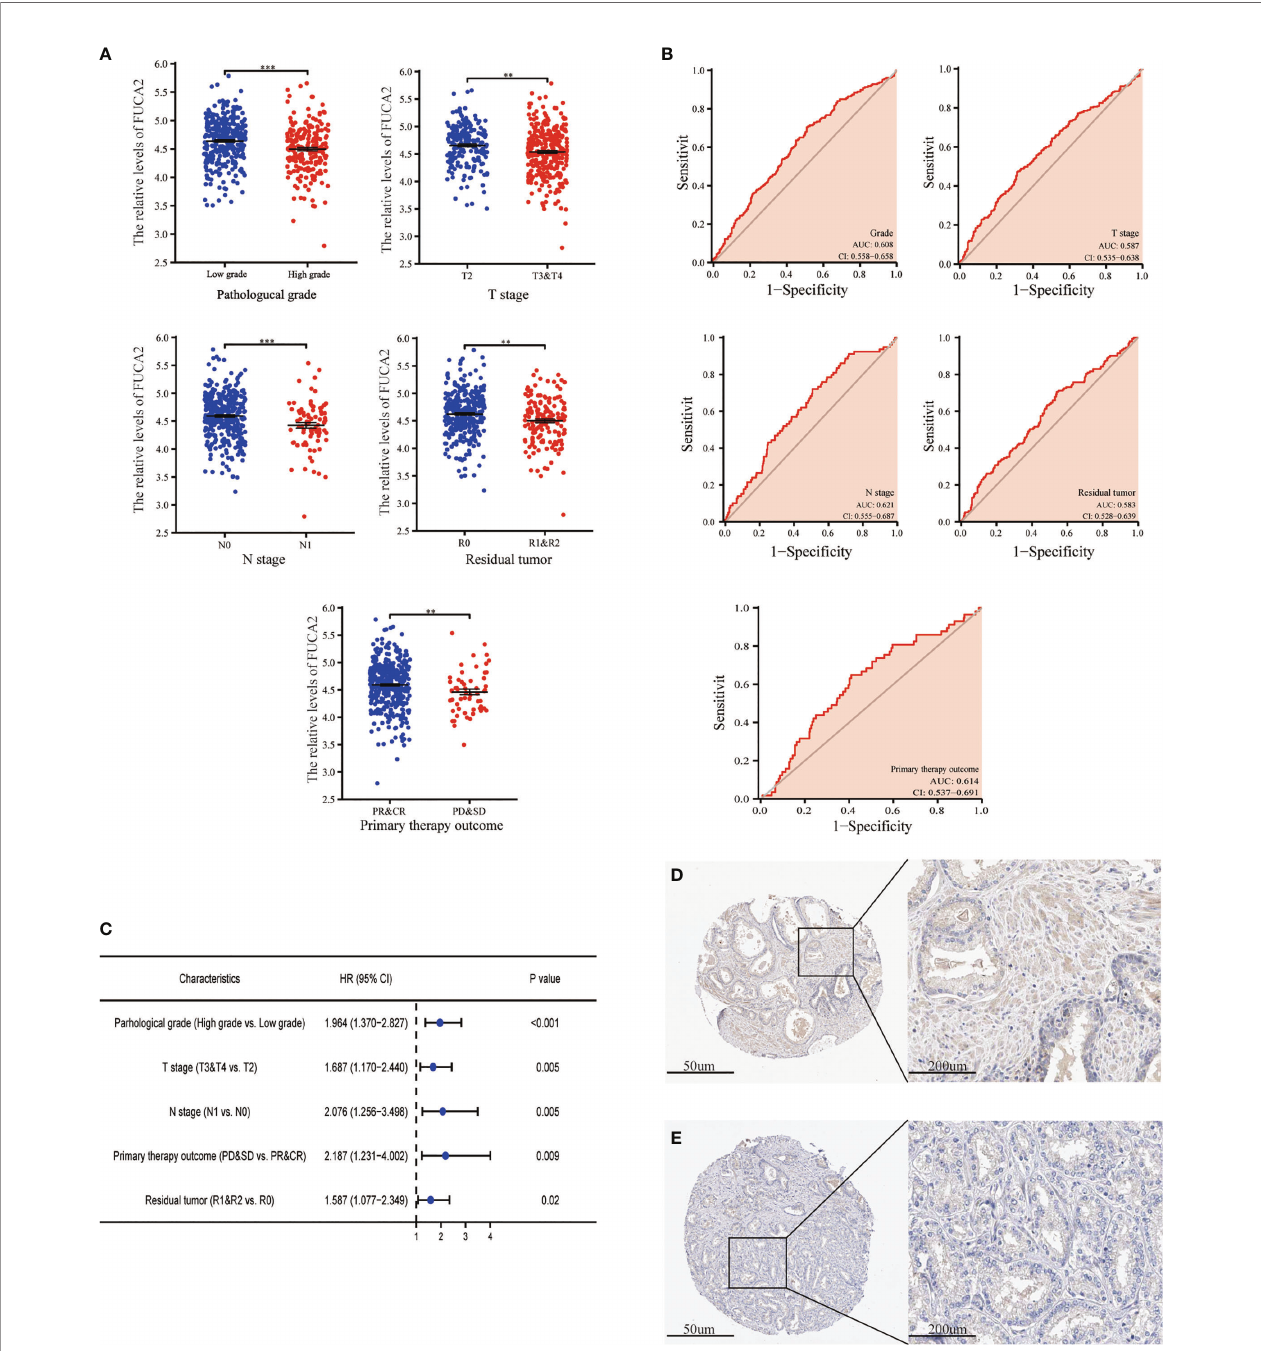
FIGURE 4 | The expression of FUCA2 in PCa subgroups. (A) FUCA2 mRNA expression in different PCa subgroups. (B) The diagnostic value of FUCA2 for different PCa clinicopathological parameters. (C) Logical regression analysis of clinicopathological variables ’ effects on low FUCA2 expression. IHC analysis of FUCA2 in low- (D) and high-grade (E) PCa tissue. CR, complete response; PR, partial response; SD, stable disease; PD, progressive disease. ** p < 0.01, *** p < 0.01. PCa, prostate cancer; IHC,